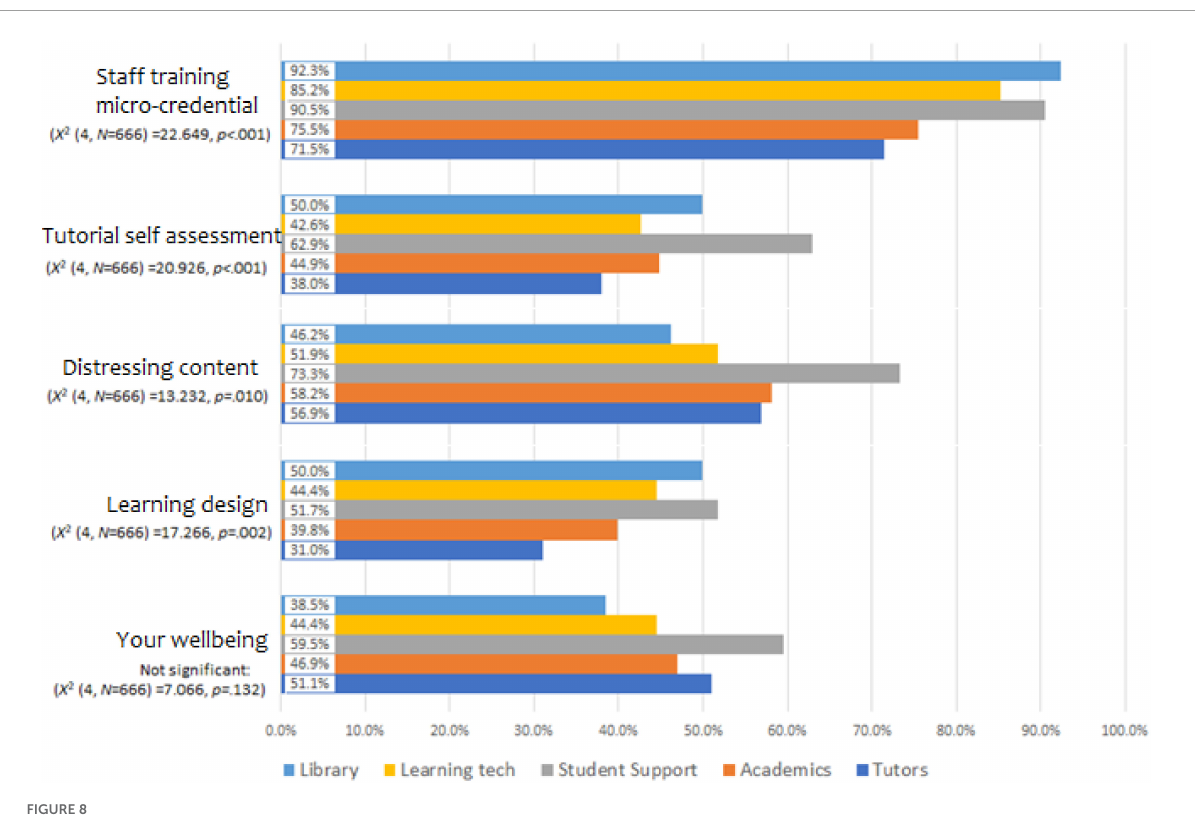
FIGURE8 Open University staff perceptions of proposed solutions to address barriers to